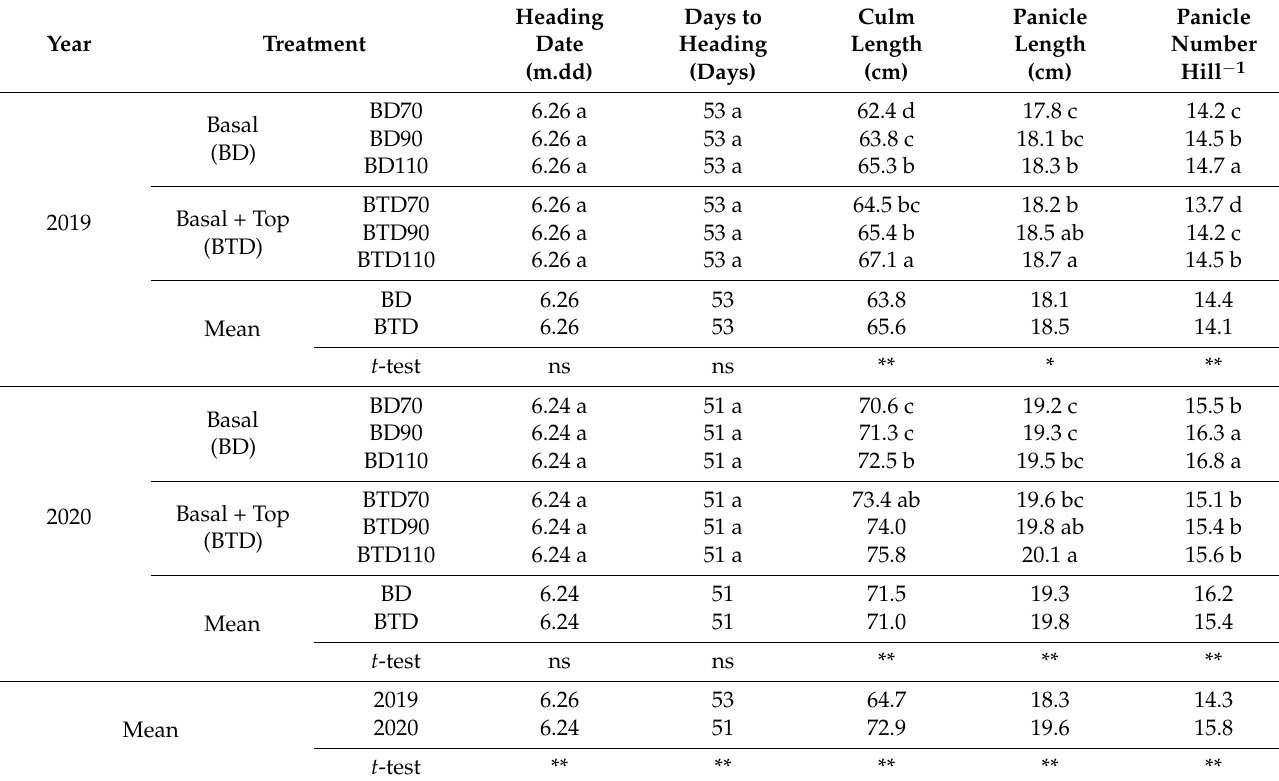
Table 3. Heading date and panicle-related traits according to nitrogen application